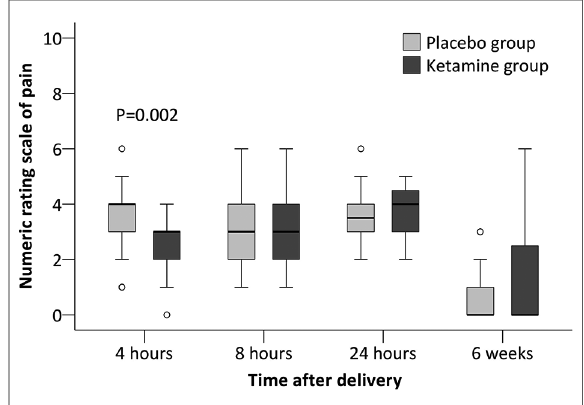
FIGURE 2 Numeric rating scale of pain at rest after cesarean delivery. The box and whiskers plots show medians, interquartile ranges, and outer ranges; individual circles indicate mild outliers (outside 1.5 times of interquartile range).